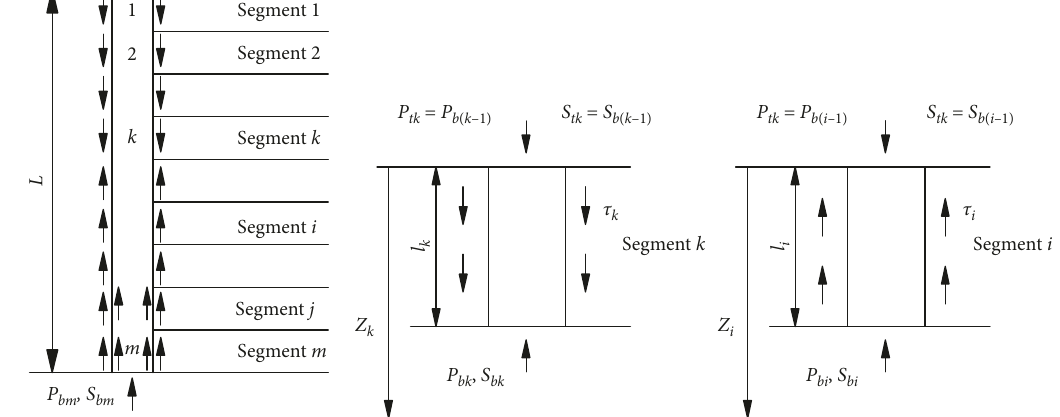
Figure 8: Schematic of force on pile